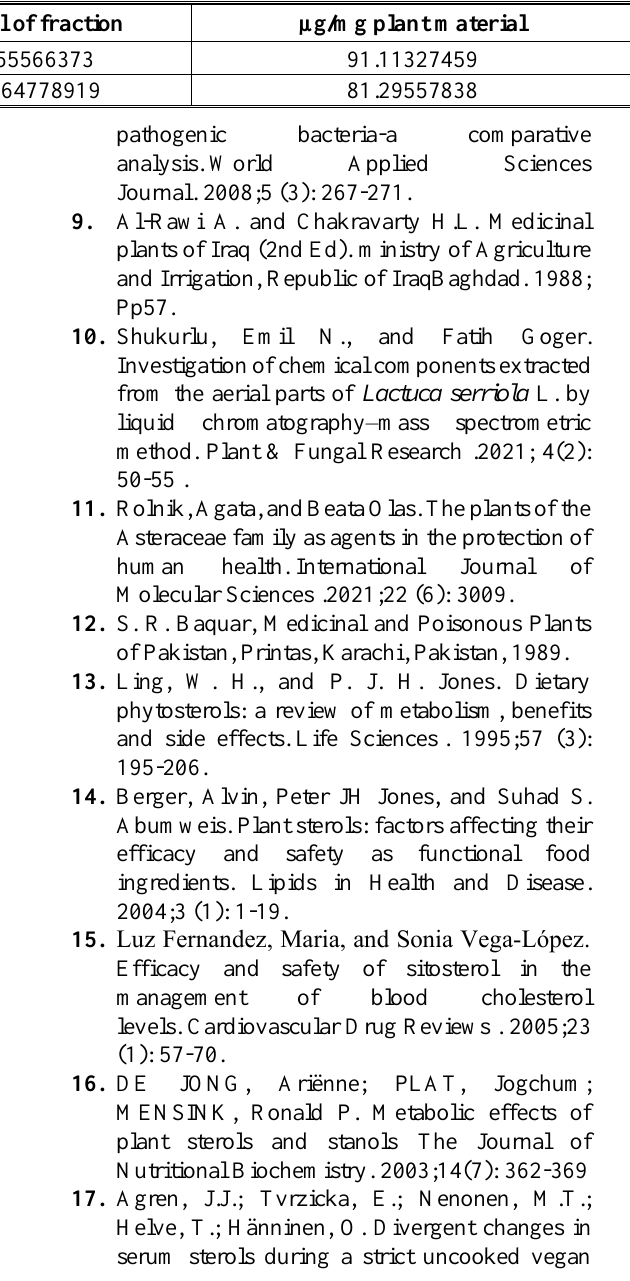
Figure 7. The calibration curve of Stigmasterol Figure 8. calibration curve of β-sitosterol Table 2. The quantity of the plant's hexane fraction that contains the predicted stigmasterol and β-sitosterol (L1 and L2)